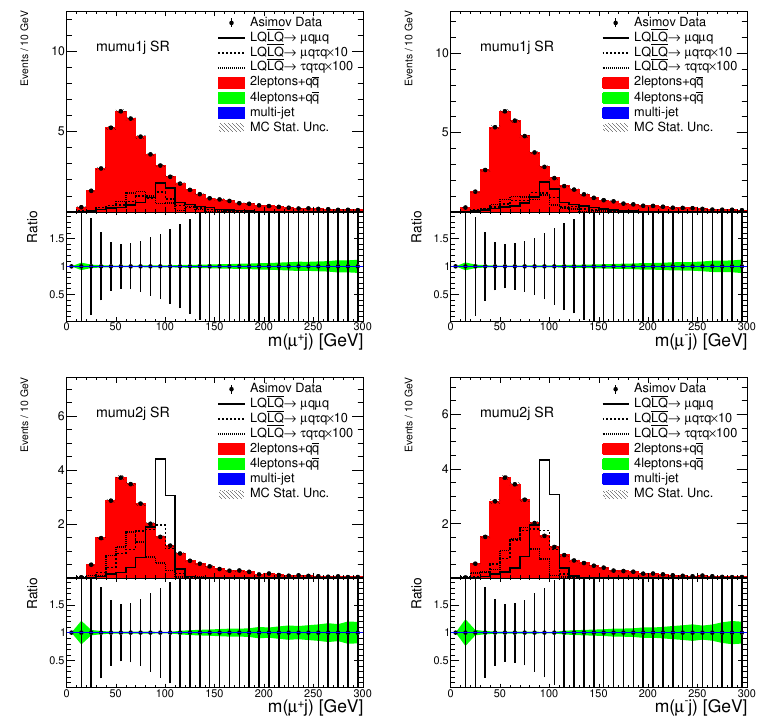
Figure 5 . The distribution of the invariant mass of a lepton candidate and a jet candidate in the signal region “mumu1j” (top) and “mumu2j” (bottom). The left one is m ( µ + j ) and the right one is m ( µ − j ) . The black points in the upper pads show the asimov data which is just the sum of all background events with uncertainties completely suppressed for better illustration. The ratio of the asimov data and the total background is shown in the lower pads, where the error bars on the black points represent the expected data uncertainty while the green bands represent the total MC statistical